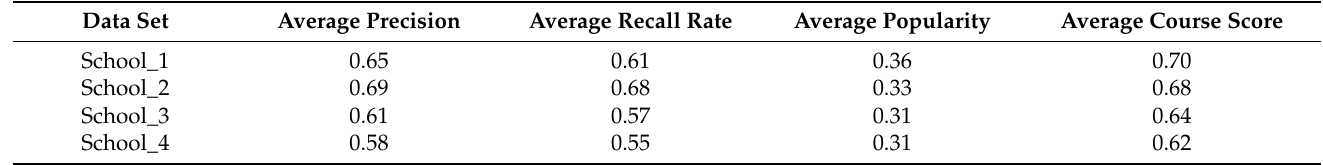
Table 7. Indicators of the course recommendation results for each